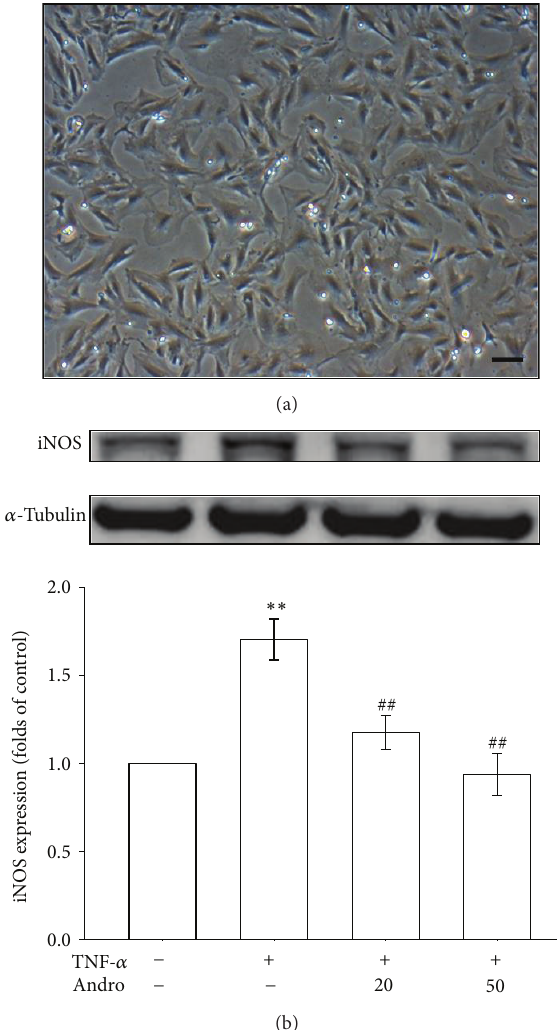
Figure 2: Effects of andrographolide on iNOS expression in TNF- 𝛼 -stimulated VSMCs. (a) Photomicrograph showing the primary cultured rat aortic VSMCs (magnification × 100). (b) The VSMCs were treated with PBS (resting group) or pretreated with andrographolide (20 and 50 𝜇 M) or an equal volume of DMSO (solvent control) for 20 min, and TNF- 𝛼 (10ng/mL) was subsequently added for 24 h. The iNOS protein level was evaluated as described in Section 2. ∗∗ 𝑃 < 0.01 compared with the resting group; ## 𝑃 < 0.01 compared with the TNF- 𝛼 group. The data are presented as the mean ± SEM ( 𝑛 = 3